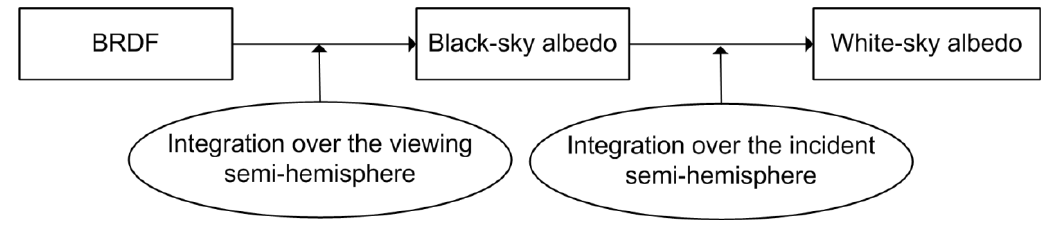
Figure A2. Flow chart of deriving the black and white-sky albedo from